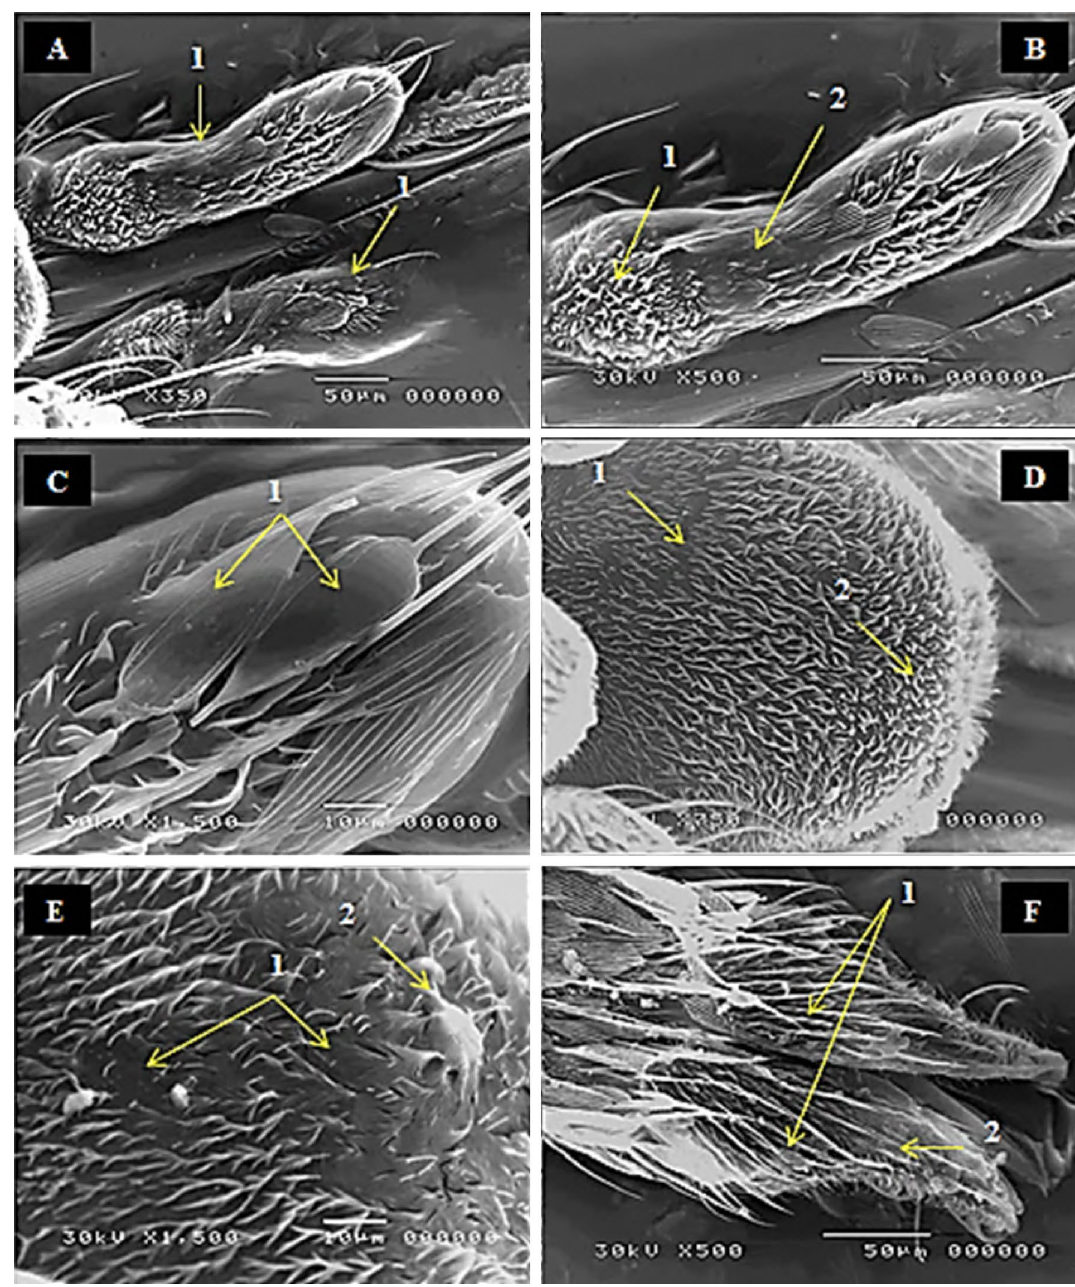
Figure 6. SEM photography of irradiated female mosquito, Culex pipiens as pupae with 40 Gy showing ( A- 1 ) liquefaction and changes in the normal shape of maxillary palp segments, ( B-1 ) dwarfed and shrinkage of microtrichia (Mt), ( B-1 ) falling of sensilla squamiformia (S.Sq). ( C-1 ) absent and disorganization of sensilla squamiformia (S.Sq) at the distal end of maxillary palp. ( D-1&2 ) lack and disorientation of sensilla trichodea (S.Tr) in some areas at the clypeus. ( E-1&2 ) Showing liquefied or shrinkage of the clypeus at higher magnification. ( F-1 ) broken of sensilla chateica (S.Ch), ( F-2 ) scarcity sensilla trichodea (S.Tr) and sensilla basiconica (S.Ba) at the labial